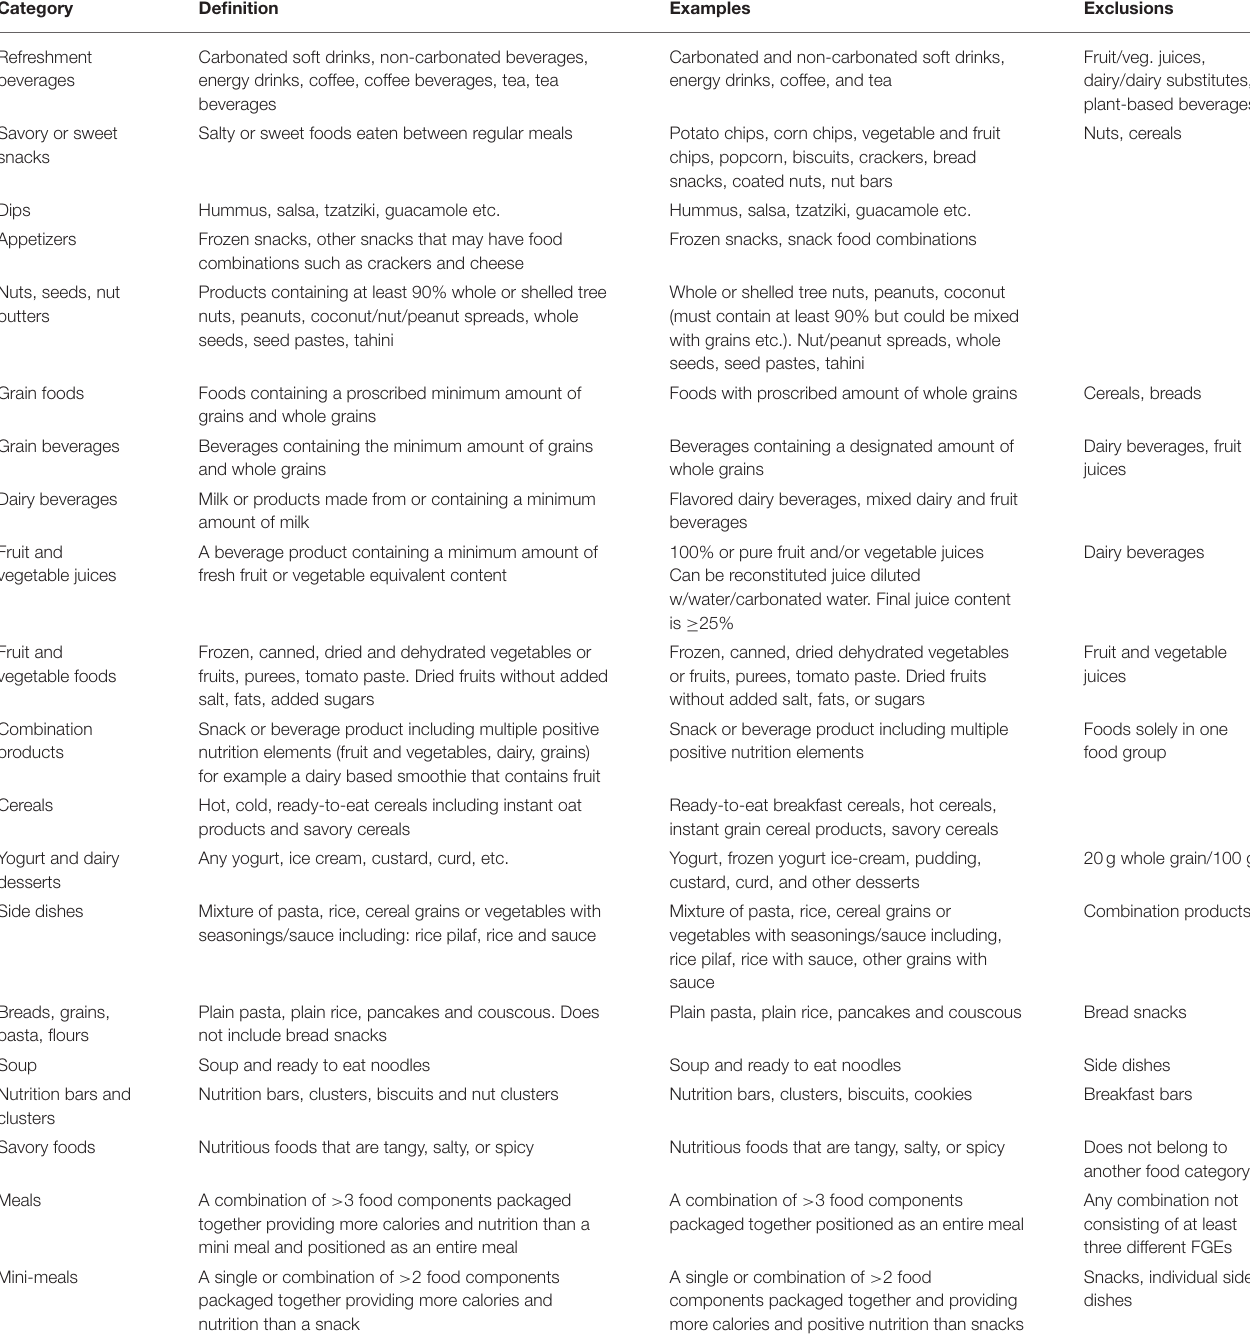
TABLE 4 | Definitions for product categories to be used as class guides for product innovation or